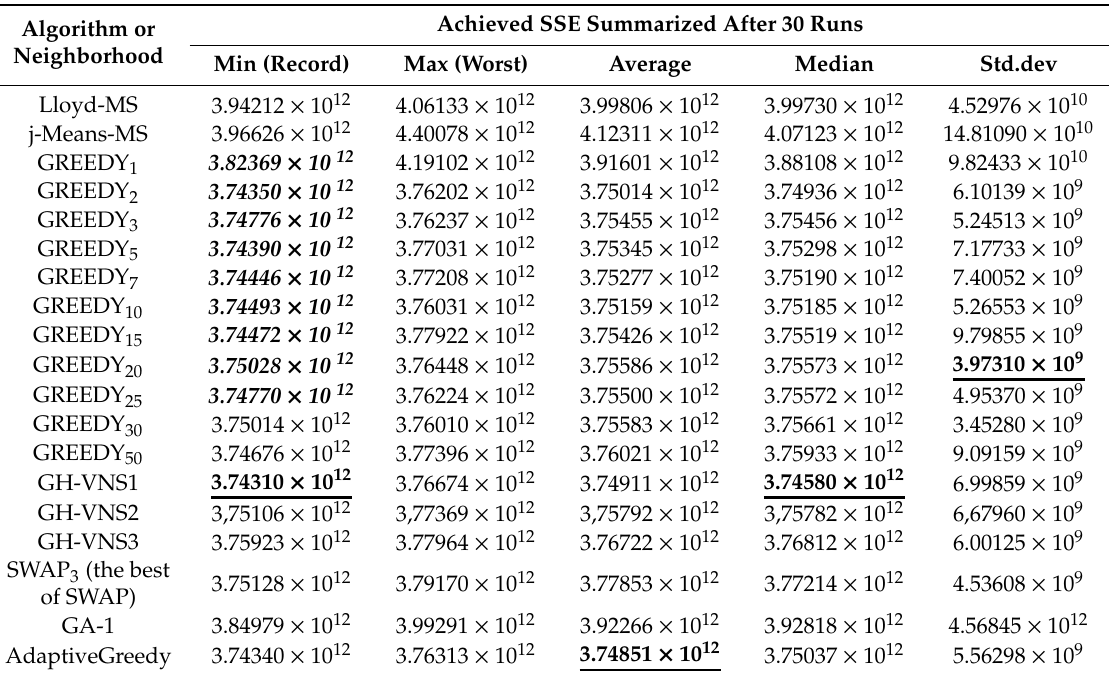
Table A10. Comparative results for Individual Household Electric Power Consumption (IHEPC)